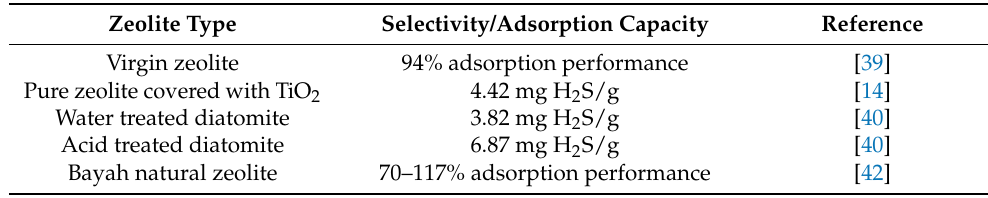
Table 4. Studies based on natural